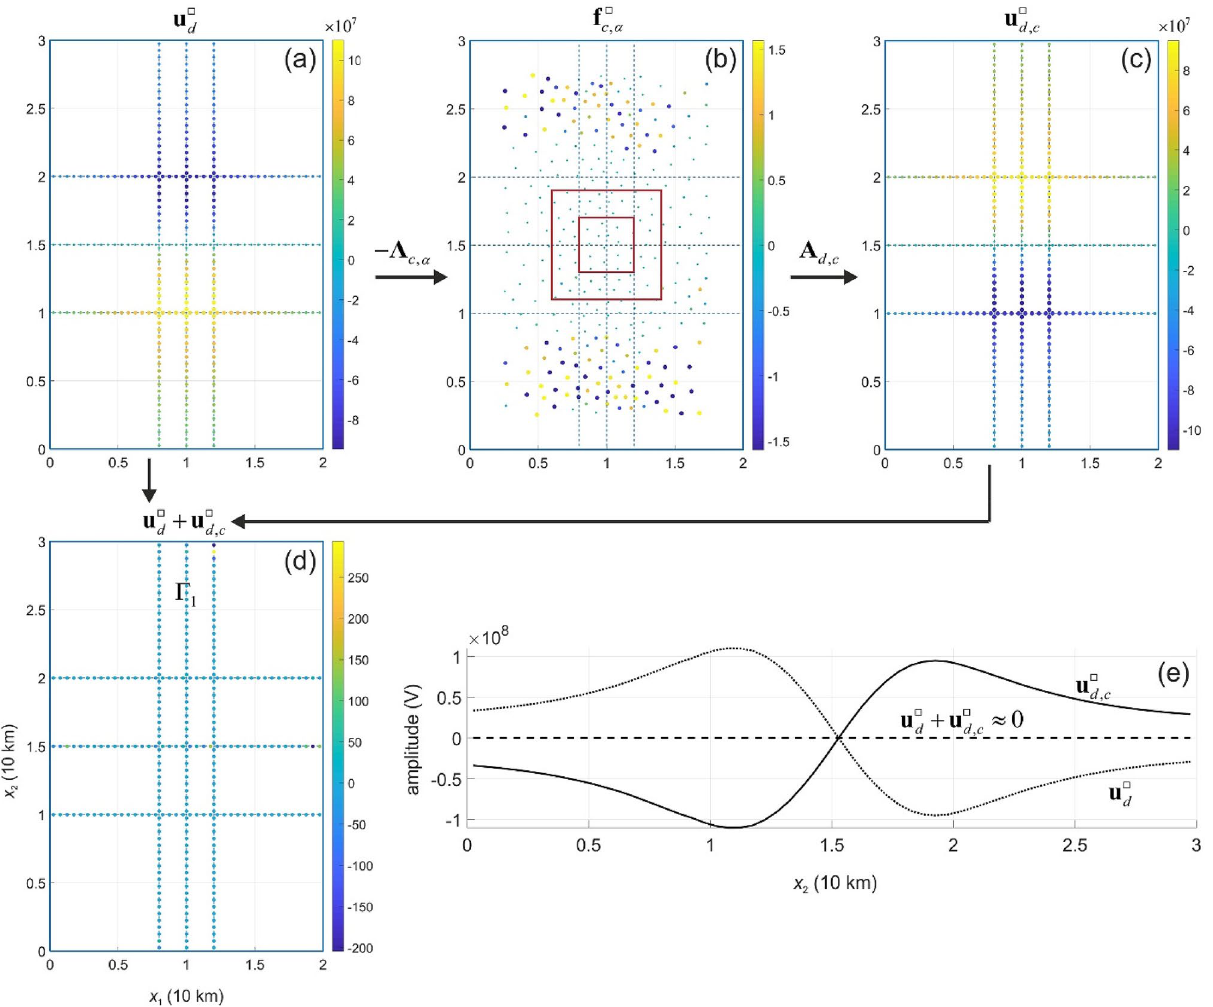
(cid:31) Ŵ ( a ) generated by the current source d on (cid:31) c , α ( b ) that (cid:31) Ŵ u (cid:31) 1 d + d , c (see dashed line) on line